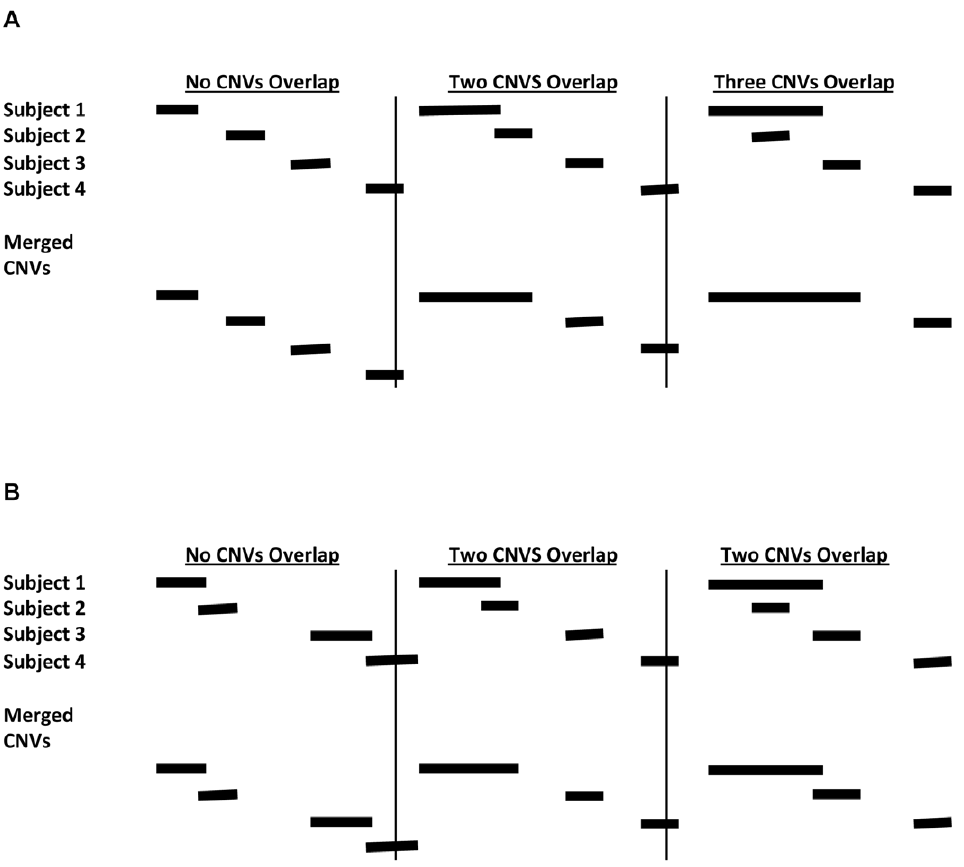
Figure 1. Illustration of how CNVs are merged based on the ‘‘any’’ overlap criterion (A) and the ‘‘40% either’’ overlap criterion (B). (A) CNVs that have any overlap are merged. The start position of the resulting CNV is defined to be the minimum base pair position of the overlapping CNVs, and the end position is defined to be the maximum base pair position of the overlapping CNVs. (B) CNVs are merged only if the length of overlap is at least 40% of the size of at least one of the CNVs. The start position of the resulting CNV is defined to be the minimum base pair position of the overlapping CNVs, and the end position is defined to be the maximum base pair position of the overlapping CNVs.